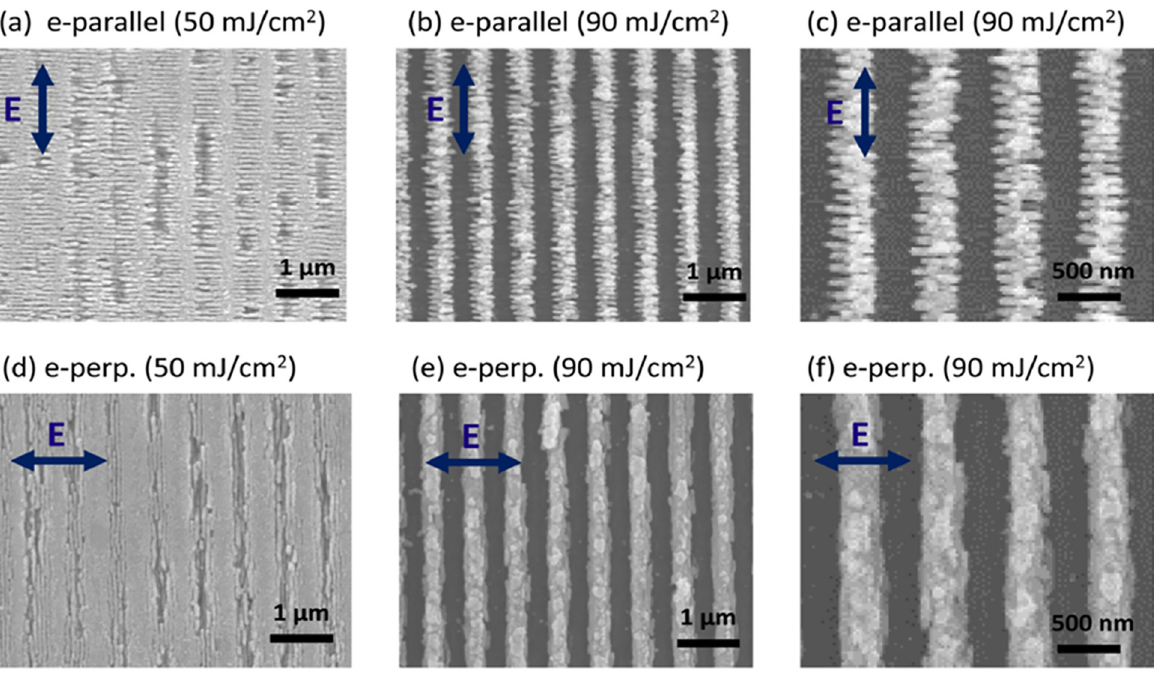
Figure 16: ITO films structured by ps-DLIP with different polarization directions (as indicated by the arrows) and fluences, which in turn, influenced the alignment and dimensions of LIPSS. Figure reproduced from ref. [146] (© 2019 Optical Society of